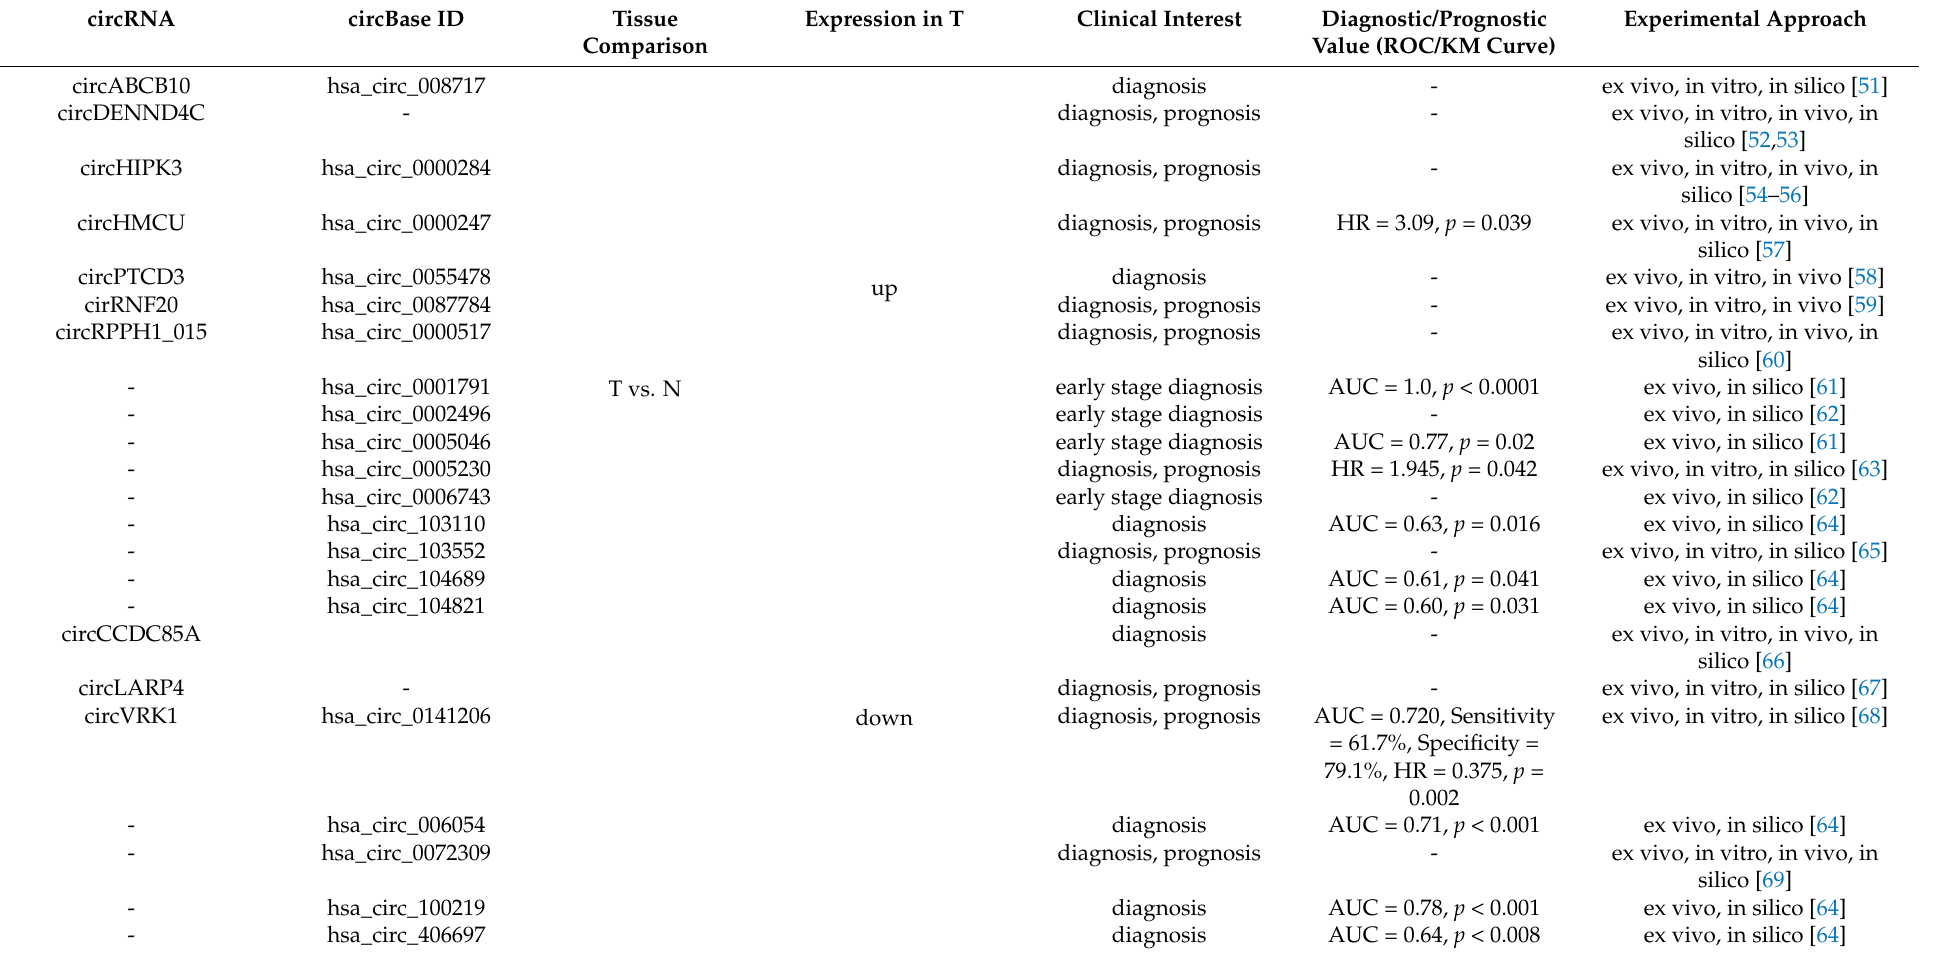
Table 1. List of circRNAs reported as potential biomarkers in breast